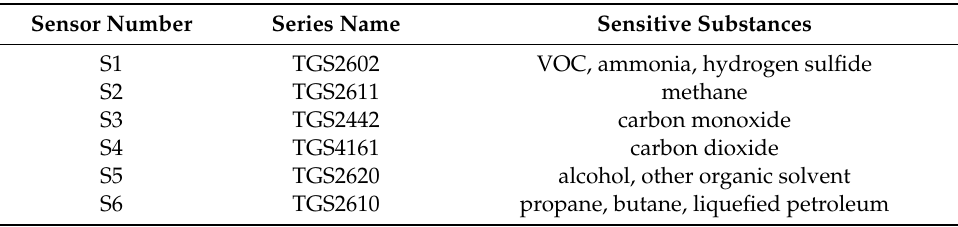
Table 1. Gas sensor array and its